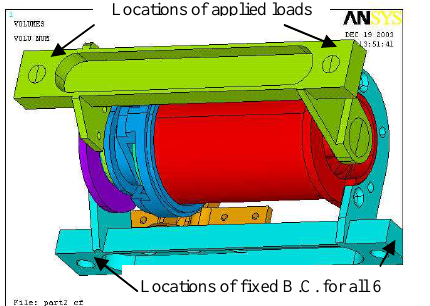
Fig. 7. Boundary Conditions and Applied Loads.